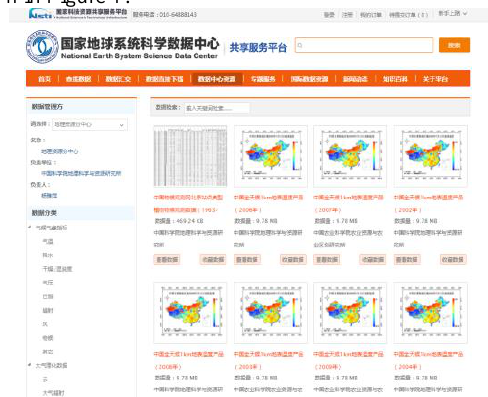
Figure 1 . Data Sharing Service Platform by NESSDC.